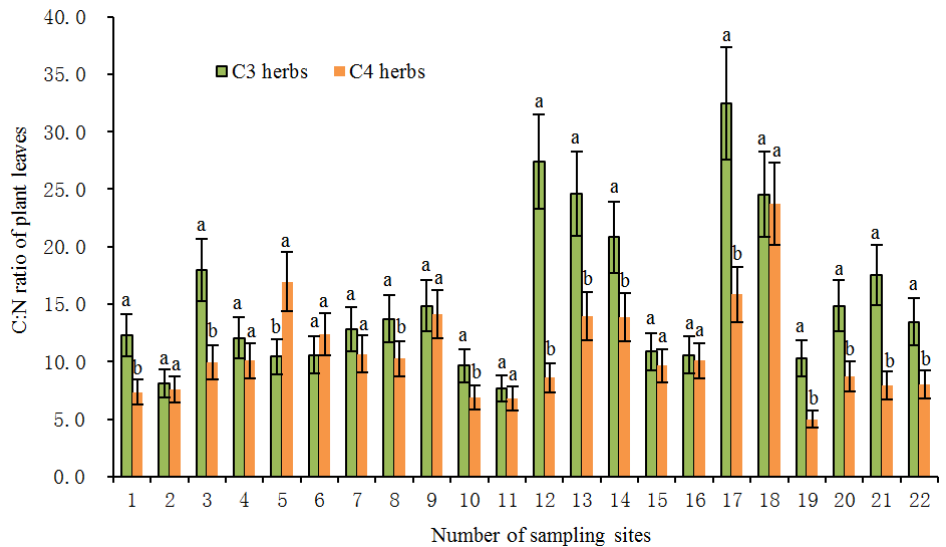
Figure 3. The C: N ratios of C3 and C4 herbs at each site in the study transect. The numbers of the sampling sites correspond to the serial number in Table 3. All the values are represented as mean ± SD (standard deviation) of each sampling site. Different letters at each site indicate significant dif- ferences according to Duncan’s single-factor variance test at the 5% level.